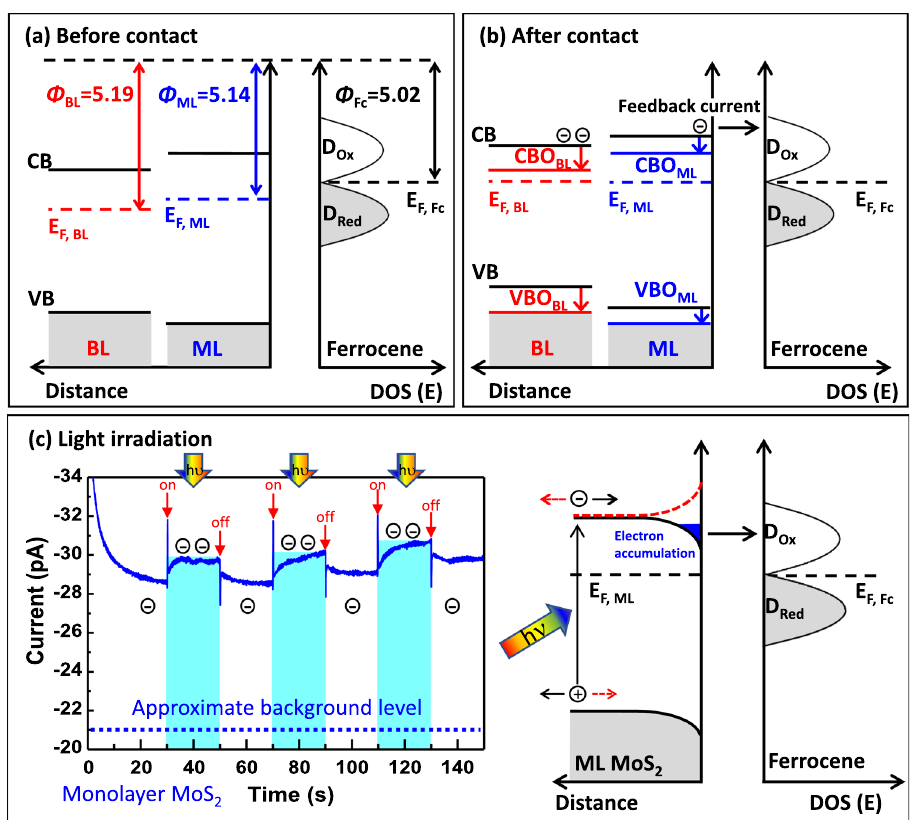
Fig. 5 Schematic illustration of layer dependent band offsets at the MoS 2 -liquid interface. a Band positions for the mono (blue) and bilayer (red) in MoS 2 and the liquid (black) before contact. Work functions ( Φ ) are unequal for the subsystems and respectively, their Fermi energies ( E F ) relative to the vacuum level ( E vac ). During solid – liquid junction formation, the work function differences cause a charge transfer with Fermi-level alignment. After contact ( b ), conduction bands (CB) and valence bands (VB) are respectively offset (CBO and VBO), and the redox potential applied drives an electron current into the unoccupied Fc + states ( D Ox ). D Red are the fi nal occupied states. c Chronoamperometric I – t curve shows a light-driven feedback current enhancement with the probe on top of a MoS 2 monolayer fl ake. At the indicated times (red arrows), a white light source ( h ν = 0.3 − 1.8 eV) is switched on for a period of 20 s, indicated by the bright blue areas. The current enhancement results from interface electron accumulation in response of light irradiation and a downward band bending (black curve), which is not present for opposite bending (red curve). The blue dotted line indicates the approximate, system related background current ( (cid:1) − 21 pA), see for discussion Supplementary Note